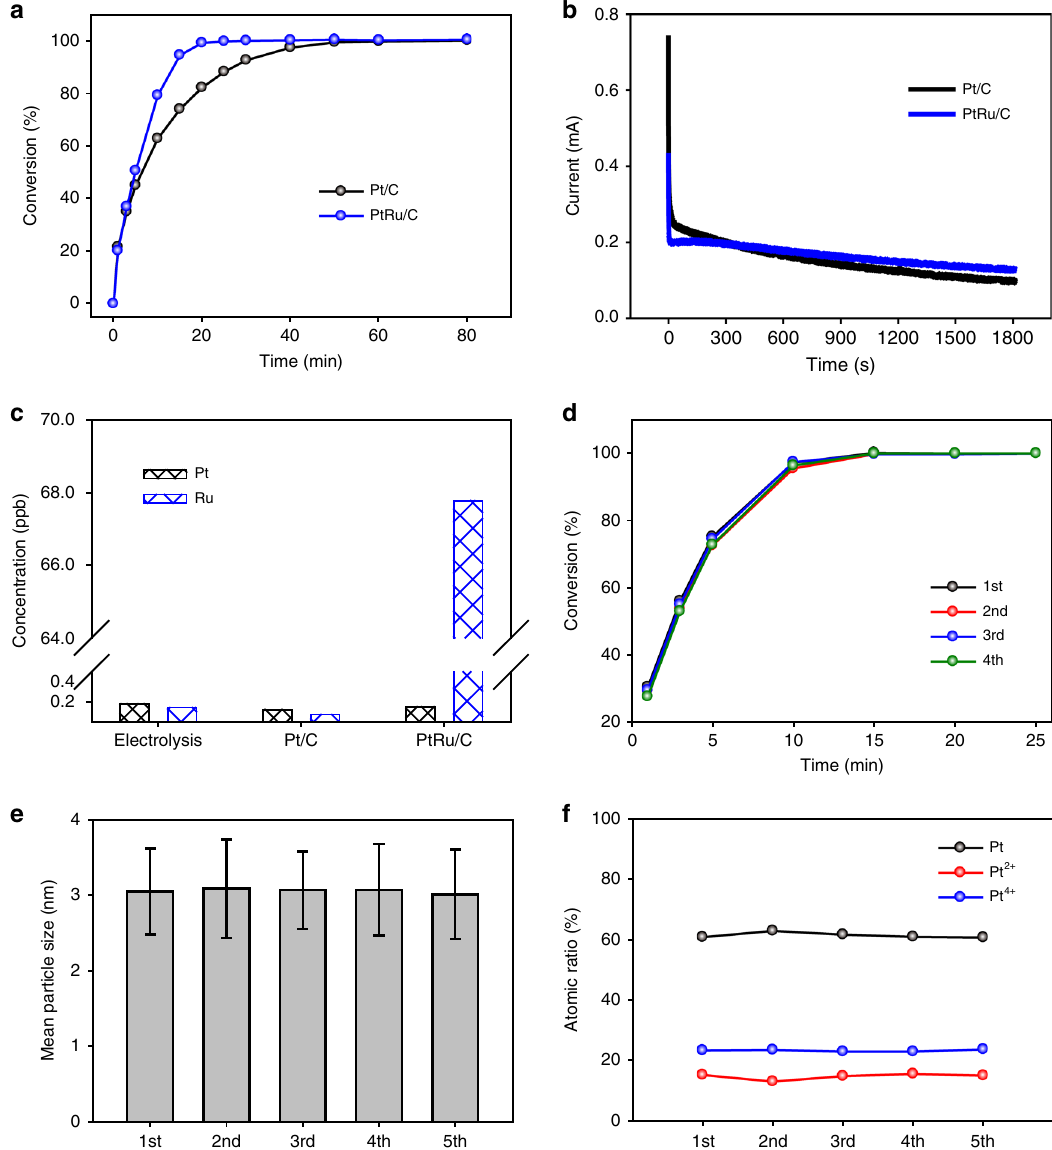
Fig. 4 Effect of catalyst on the catalytic reduction. a Conversion of the V 4 + electrolyte with Pt/C and PtRu/C. b Chronoamperometry (CA) test for the oxidation of formic acid on Pt/C and PtRu/C electrodes; stability of Pt/C and PtRu/C for the catalytic reduction. c Inductively coupled plasma (ICP) analysis results for the diluted electrolytes from electrolysis and catalytic reaction with Pt/C and PtRu/C at 80 °C for 30 min. d Plots of conversion as a function of reaction time for the repeated catalytic reductions at 80 °C without refreshing Pt/C. Variation of e mean particle size and f surface composition of Pt/C with the repeated usage, as determined by transmission electron microscopy (TEM) and X-ray photoelectron spectroscopy (XPS) analysis, respectively. The error bars represent the standard errors. Source data are provided as a Source Data fi